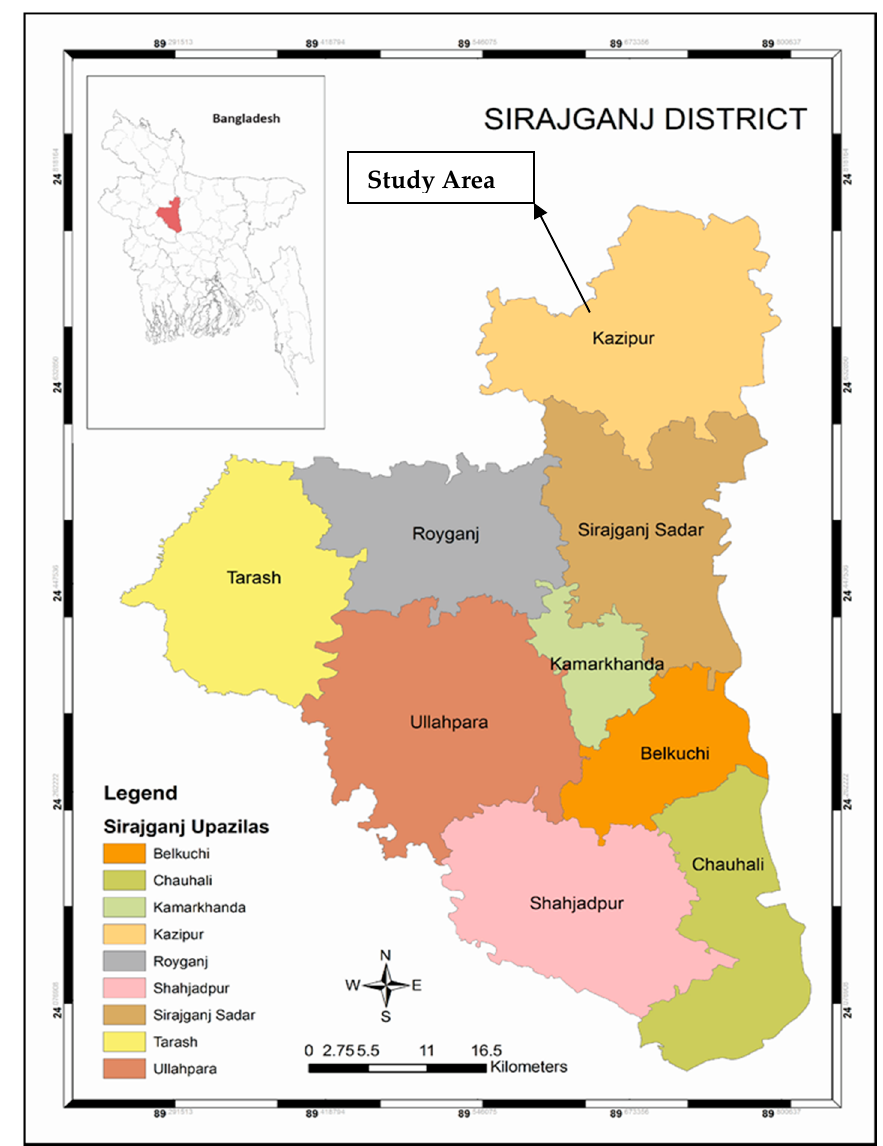
Figure 1. Location map of the Sirajganj District.